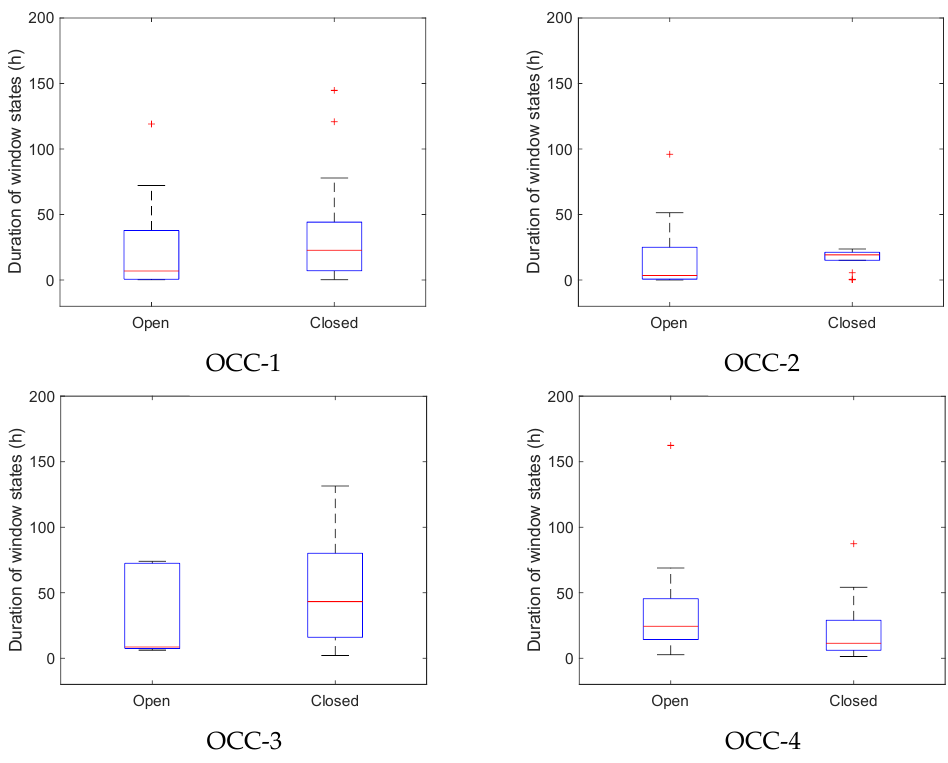
Figure 4. Duration of window opening and closing.